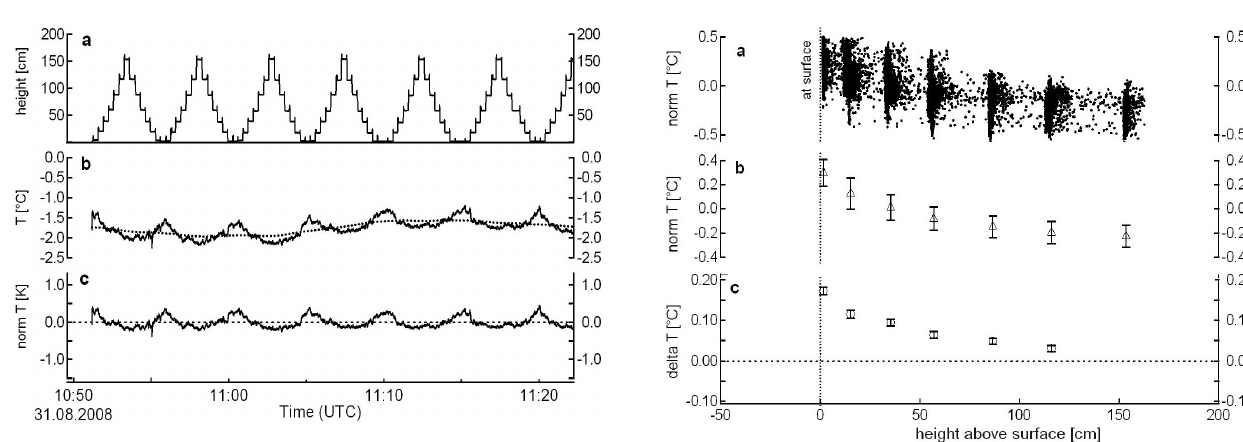
Fig. 2. Temperature data acquired with the gradient pole on 31 Au- gust over the frozen lead: (a) measurement height [cm], (b) temper- ature [ ◦ C], (c) normalized temperature [K].